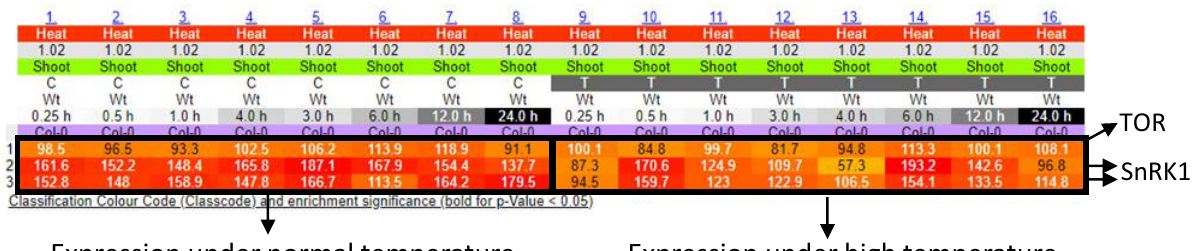
Figure 4. Time course expression patterns of SnRK1 and TOR genes in response to high temperature. The results were obtained from the e-Northerns w. Expression Browser (http://bar.utoronto.ca/ affydb/cgi-bin/affy_db_exprss_browser_in.cgi accessed on 20 January